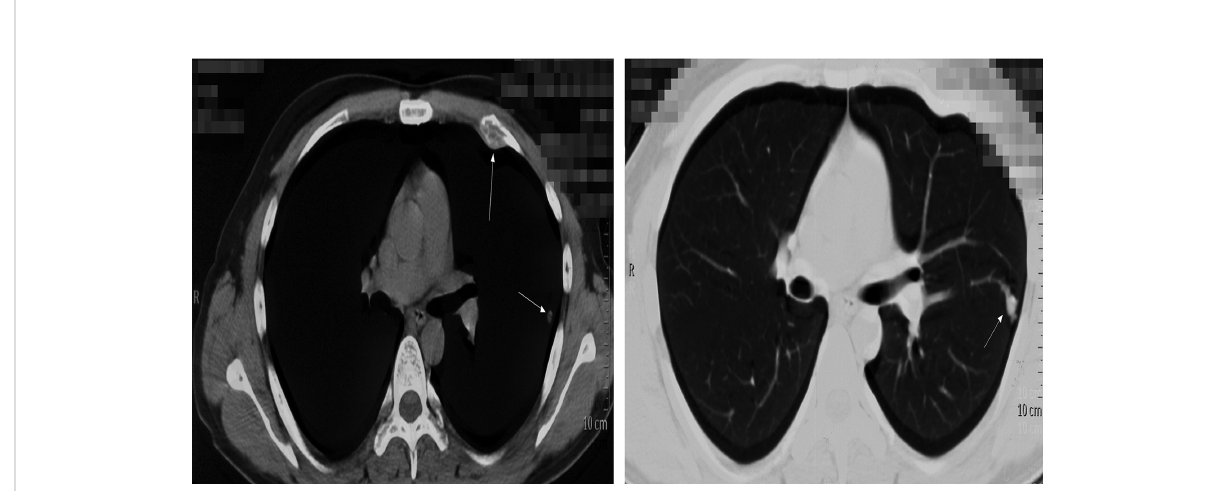
FIGURE 3 Thoracic CT demonstrated the metastatic lesions of the rib, left lung lobe. White arrows indicate the